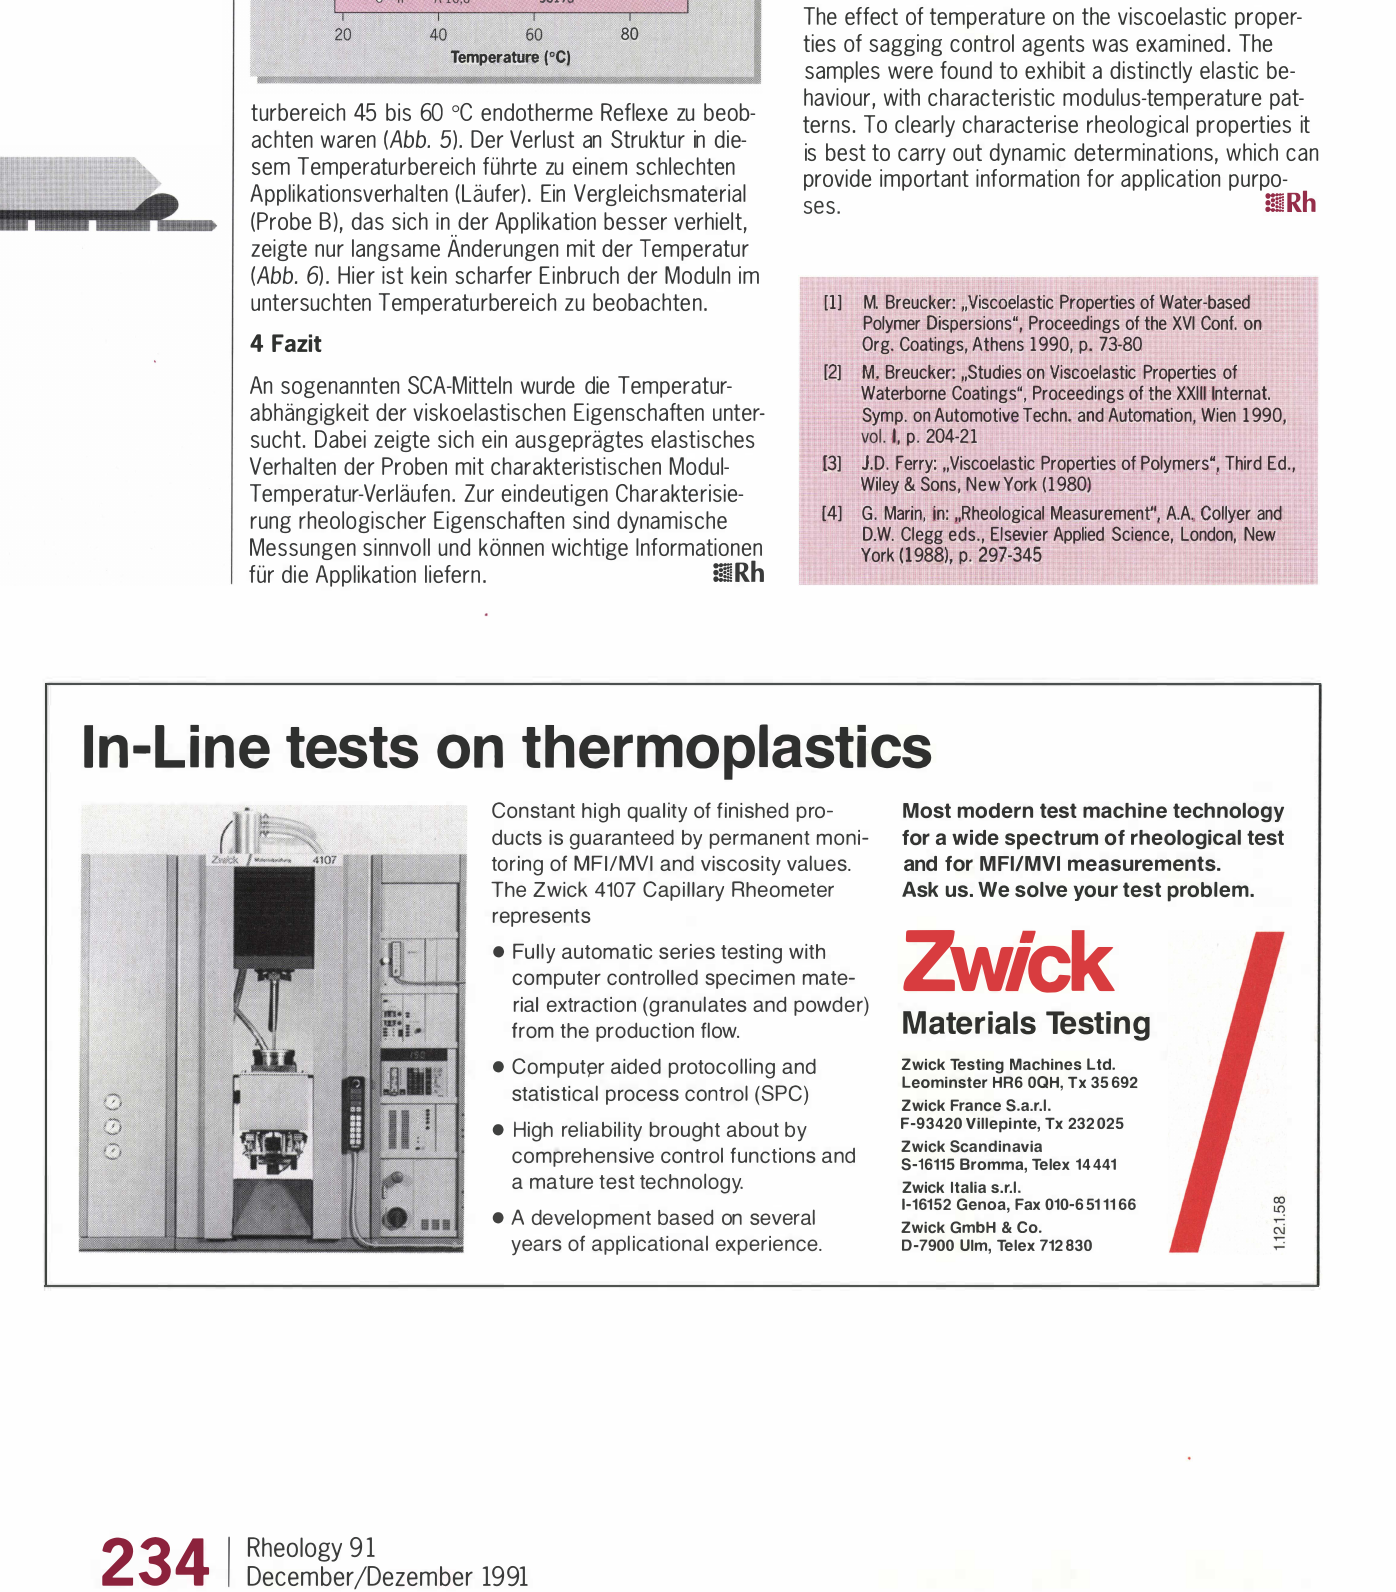
Fig. 6: Temperature-dependent behaviour of comparative sample